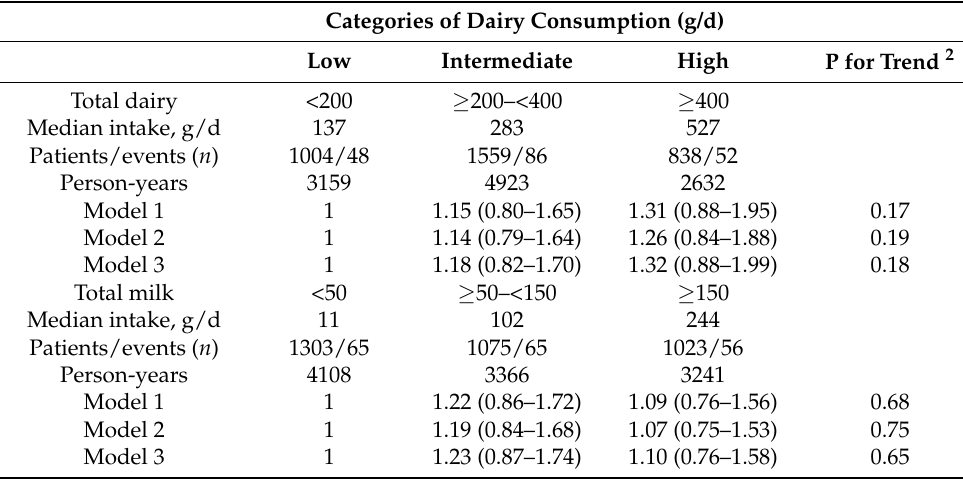
Table 2. HRs (95% CIs) for type 2 diabetes according to categories of types of dairy consumption